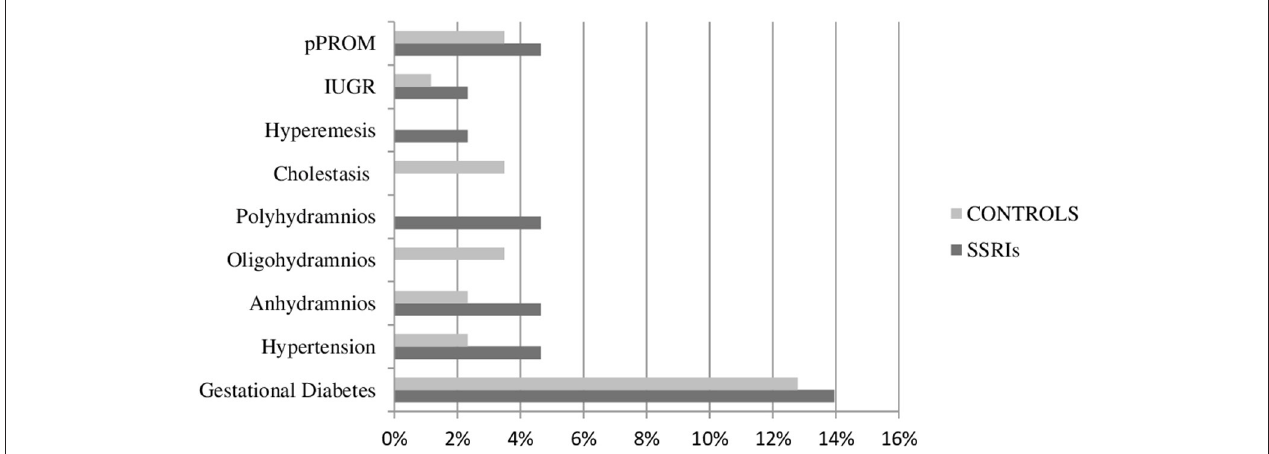
FIGURE 2 | Pregnancy complications in the study population. Data are presented as percentage of women (%) on the population. SSRIs, selective serotonin reuptake inhibitors; IUGR, intrauterine growth restriction; pPROM, preterm premature rupture of